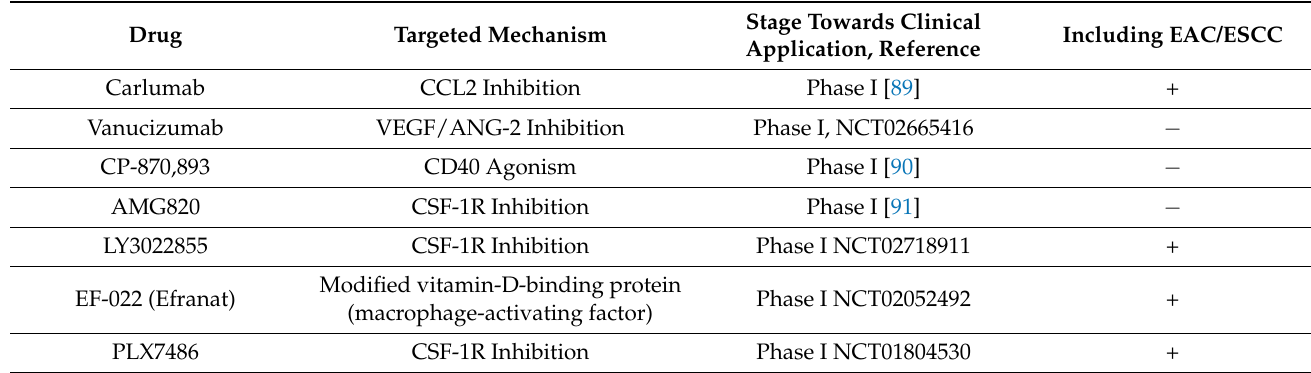
Table 1. Overview of macrophage targeting therapies in clinical Phase I trials. Please note that the last column indicates inclusion or eligibility of esophagogastric cancers or ESCC (+) or not ( − ). Drug Targeted Mechanism